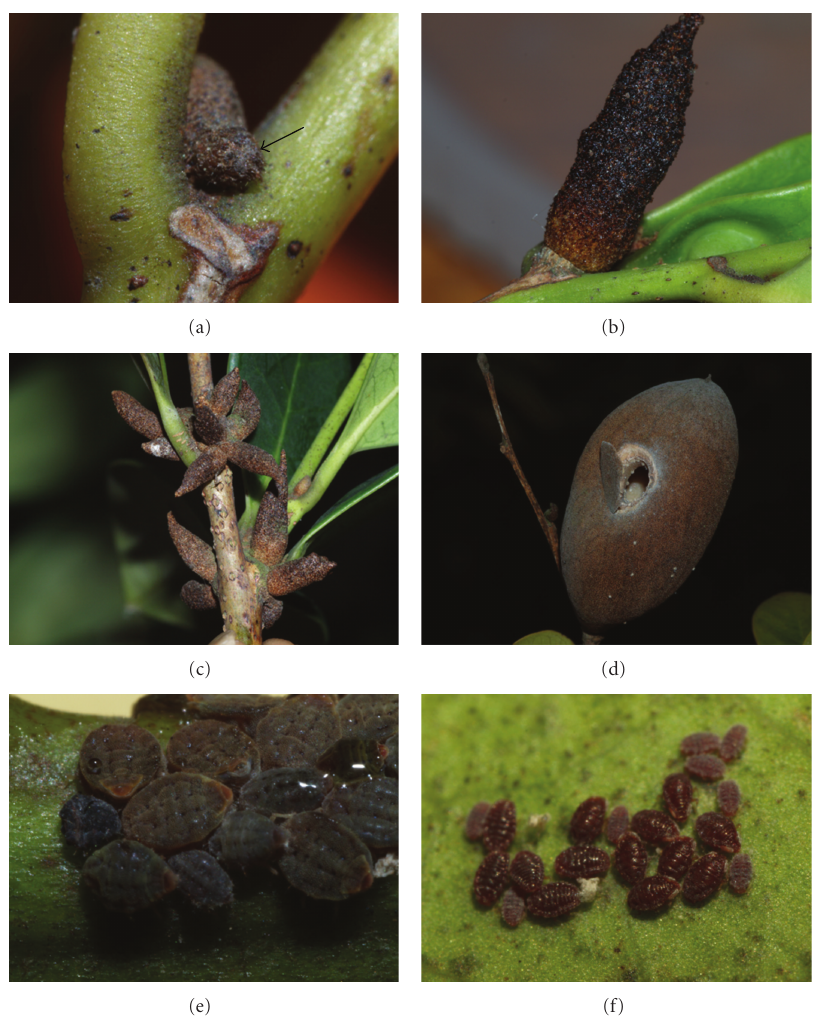
Figure 1: Nipponaphis monzeni : (a) an overwintered tiny gall (on 12 March 2008) that was formed on the base of an axillary bud of Distylium racemosum in the previous year; (b) after the first winter such a gall has grown to a cone-shaped gall (on 19 May 2008); (c) several cone- shaped galls with the hardened wall (on 29 October 2007); (d) a full-grown gall with a round exit hole (on 8 December 2008); (e) secondary- host generation (apterae and nymphs) on a twig of Lithocarpus edulis (on 9 January 2008); (e) sexuals on the underside of a leaf of D. racemosum (on 30 April